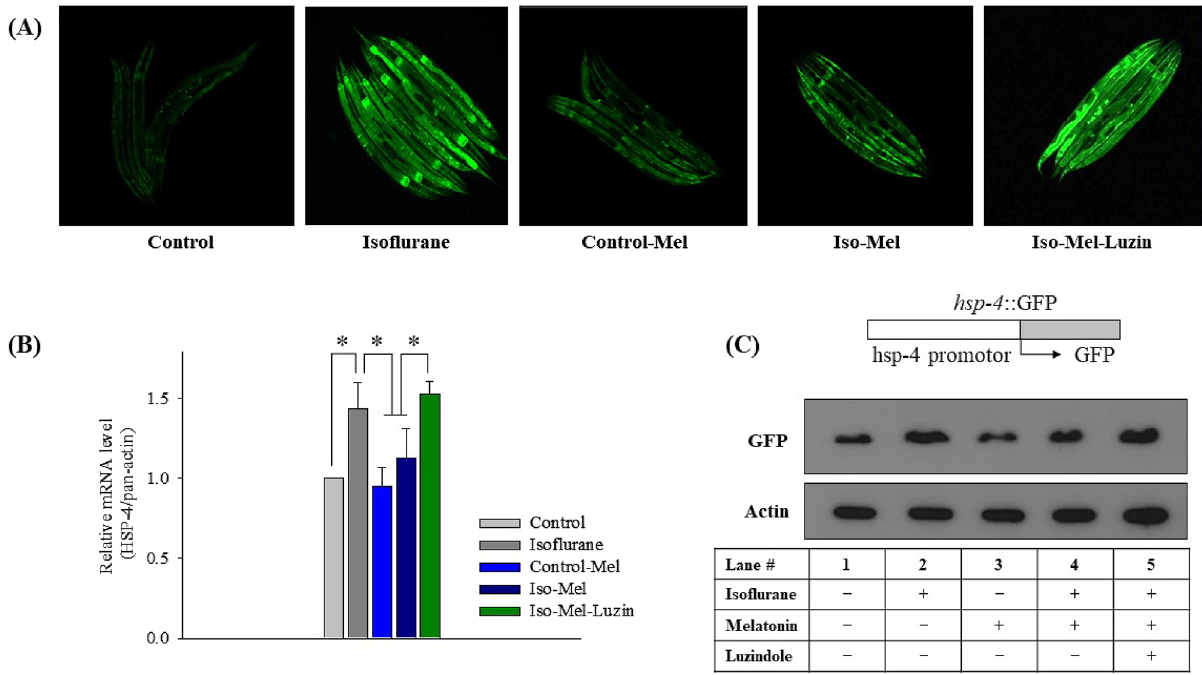
Figure 1. Phsp-4::GFP expression in young adults after repeated isoflurane exposure with or without concurrent melatonin or luzindole treatment. ( A ) Phsp-4::GFP expression. Phsp-4::GFP expression was increased significantly after isoflurane exposure, while it was decreased with concurrent melatonin treatment. The inhibitory effect of melatonin on Phsp-4::GFP expression was significantly suppressed by luzindole. The experiments measuring GFP were performed 5 times and 5–10 worms per condition were monitored in each experiment. ( B ) Expression of the hsp-4 gene. All batches included three plates in each group, and the same assay was performed three times. ( C ) Schematic diagram of the hsp-4:: GFP reporter construction and western blot for GFP expression. Western blot analysis was performed by using equal amounts of protein lysate prepared from approximately 500 worms. Error bar, standard deviation; *P < 0.05 vs . the control group; † P < 0.05 vs .